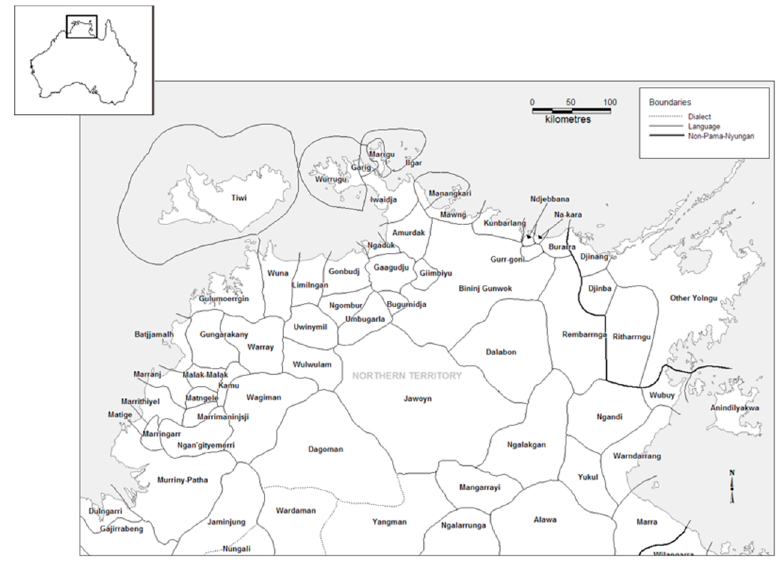
Figure 1. Languages of norther Australia (Harvey 2008).